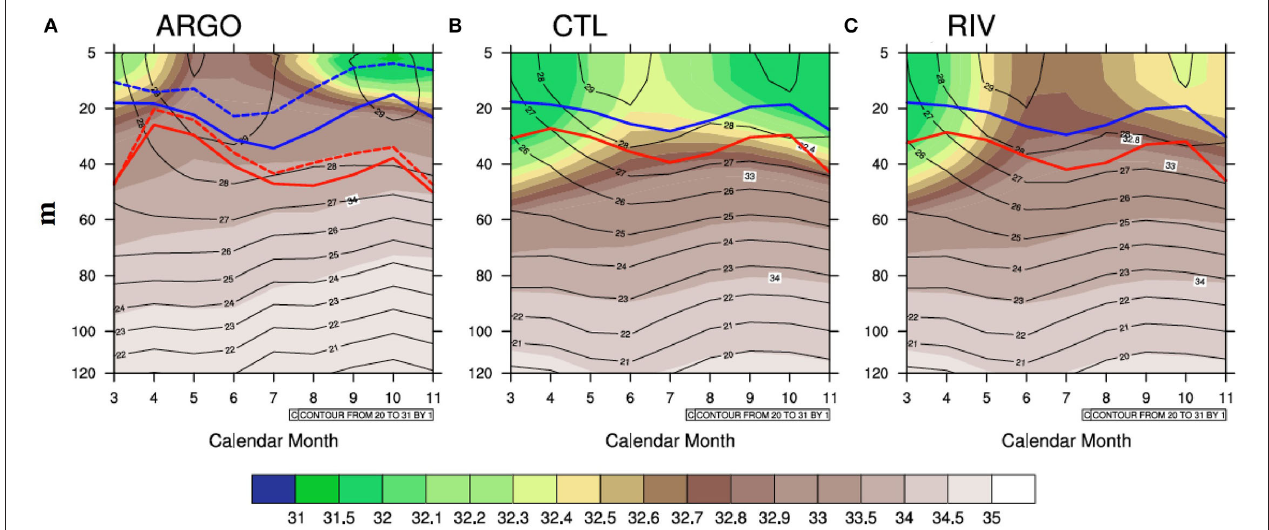
FIGURE 4 | Monthly averaged salinity profiles (psu, shading) and temperature (contours, ◦ C) for the North Bay of Bengal from (A) ARGO observations, (B) CTL run and (C) RIV run. Also depicted are the mixed layer depth (in meters, blue curve) and the isothermal layer depth (in m, red) curves. The broken blue and red curves in (A) denote the mixed layer depth (MLD) and isothermal layer depth (ILD), respectively, from the World Ocean Atlas (WOA) data, while the solid blue and red curves depict the MLD and ILD, respectively, from the ARGO